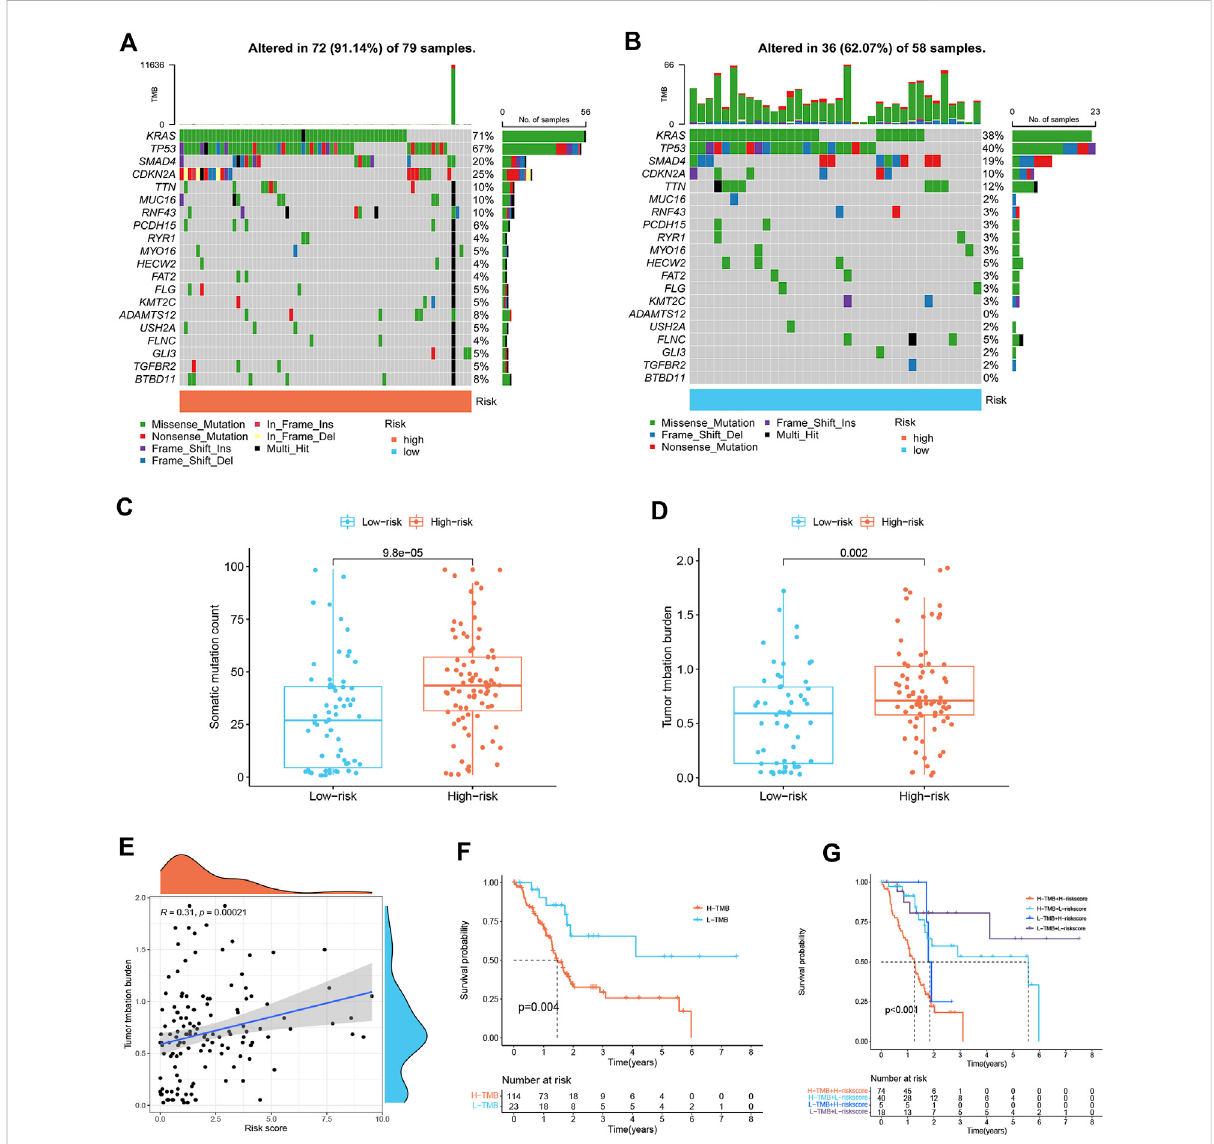
FIGURE 6 Mutationlandscapeofdifferentriskscoresubgroups( n =137). (A,B) Waterfallplotsshowhighermutationfrequencygenesinhigh- (A) andlow- risk groups (B) . (C) Boxplot for differences in somatic mutation count between two risk subgroups. (D) Boxplot for differences in TMB between two risk subgroups. (E) Correlation analysis between TMB and risk score. (F) Survival curves of PDAC patients in H-TMB and L-TMB groups. (G) Survival curves. The risk score and TMB were combined to perform survival